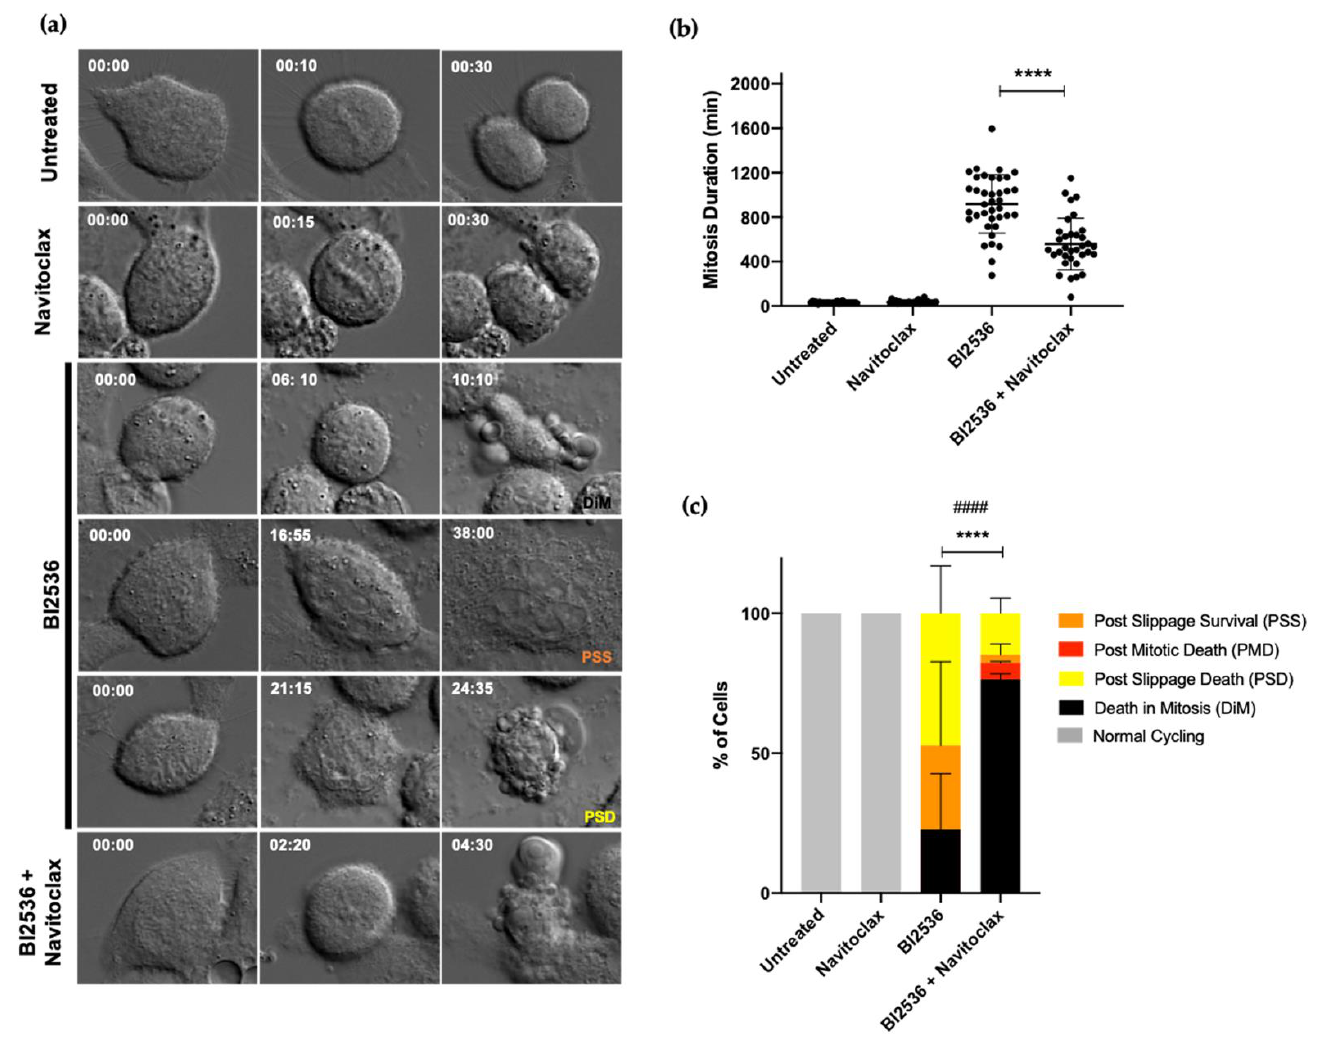
Figure 4. Navitoclax prevents slippage and accelerates cell death in mitosis in lung cancer cells treated with BI2536. ( a ) Representative time-lapse sequences of untreated, BI2536-, Navitoclax-, and BI2536/Navitoclax-treated cells. Untreated ( n = 27) and Navitoclax-treated cells ( n = 25) undertake mitosis for about 30 min. BI2536-treated cells ( n = 38) arrest in mitosis during several hours (918.2 ± 263.5 min) and die in mitosis (top) or undergo slippage followed by death (bottom) or remain alive (middle). BI2536/Navitoclax-treated cells ( n = 34) spend less time in mitosis (558.3 ± 232.0 min) than BI2526-treated cells. Numbers indicate time in 00 h:00 min. ( b ) Quantification of mitosis duration in the different treatments, as determined by time-lapse microscopy, with statistical relevance of **** p < 0.0001 by one- way ANOVA with Tukey’s multiple co mparisons test. Each dot represents one cell. ( c ) Quantification of cell fate under the indicated treatments. Percentage of cells undergoing death in mitosis (DiM), post-mitotic death (PMD), post slippage death (PSD), cells that remain alive after slippage (post slippage survival, PSS), and cells with normal cycling, with statistical relevance of **** p < 0.0001 (DiM) and #### p < 0.0001 (Slippage [PSD +PSS]) by two- way ANOVA with Tukey’s multiple comparisons test. The error bars represent mean ± SD of three independent experiments. A549 tumor cells were treated with BI2536 and Navitoclax, alone or in combination, and each cell was followed over 48 h live-cell time-lapse analysis. As expected, BI2536- treated cells lasted in mitosis for several hours (918.2 ± 263.5 min) (Figure 4b), while un- treated and Navitoclax-treated cells undertook mitosis for about 30 min (30.5 ± 7.3 min and 36.0 ± 14.1 min, respectively) (Figure 4b, Video S1 and Video S2, respectively). Inter- estingly, the addition of Navitoclax to BI2536-treated cells shortened the duration of mi- totic arrest (558.2 ± 232.0 min) as compared to cells treated with BI2536 only, suggesting